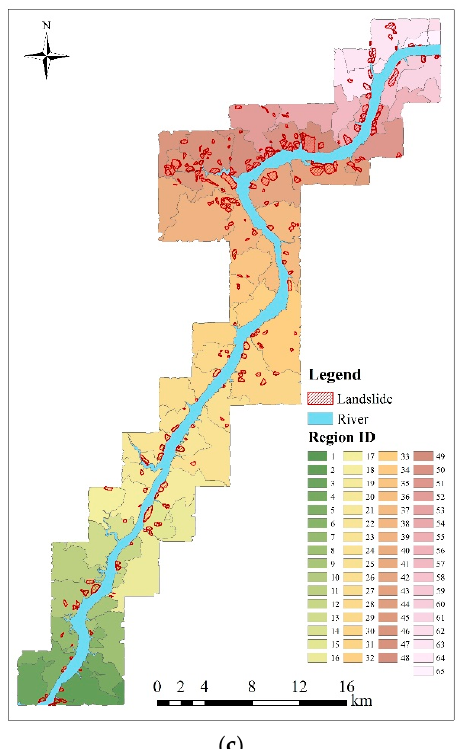
Figure 19. The performance of segmentation with respect to different values of N . ( a ) N = 2; ( b ) N = 3; ( c ) N = 4.